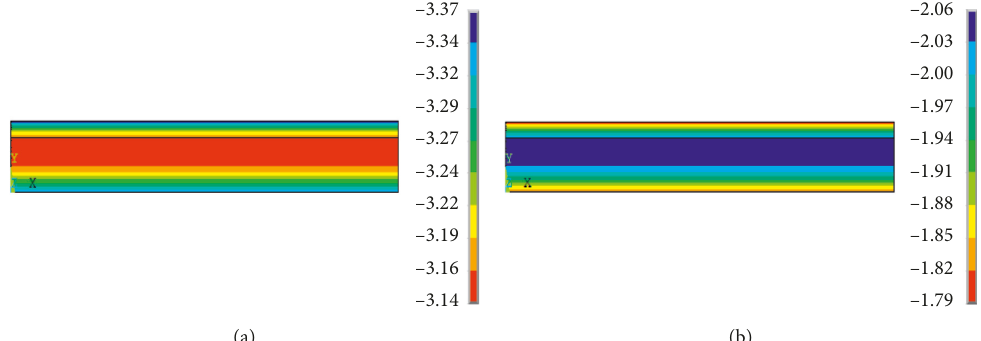
Figure 6: Surface temperature distribution ( ° C) of HSMP without insulating the bottom (a) at 6 :00 and (b) at 16:00.